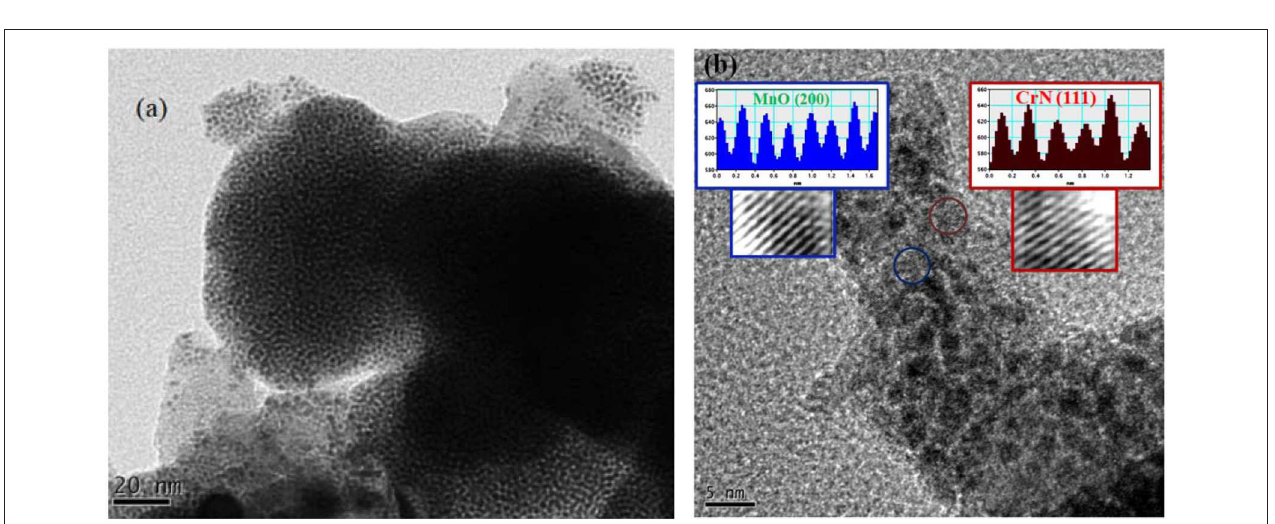
FIGURE 6 | (a,b) TEM images of Cr/rGO nanocomposite with MnO, synthesized at 900 ◦ C in 9h. TEM, transmission electron microscopy; rGO, reduced graphene